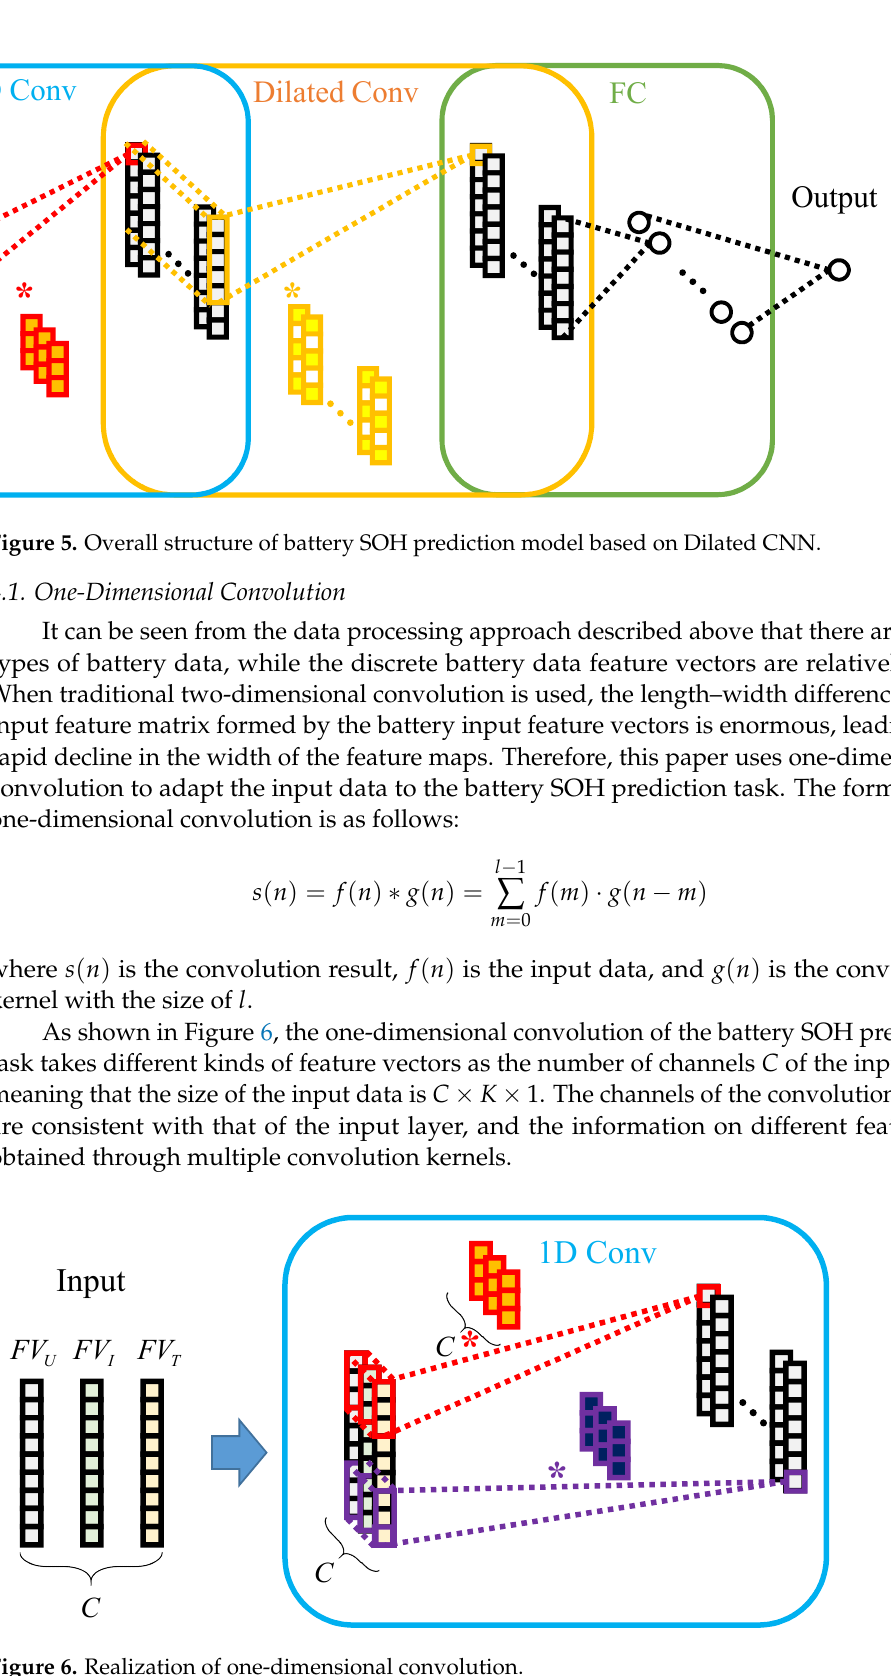
Figure 6. Realization of one-dimensional